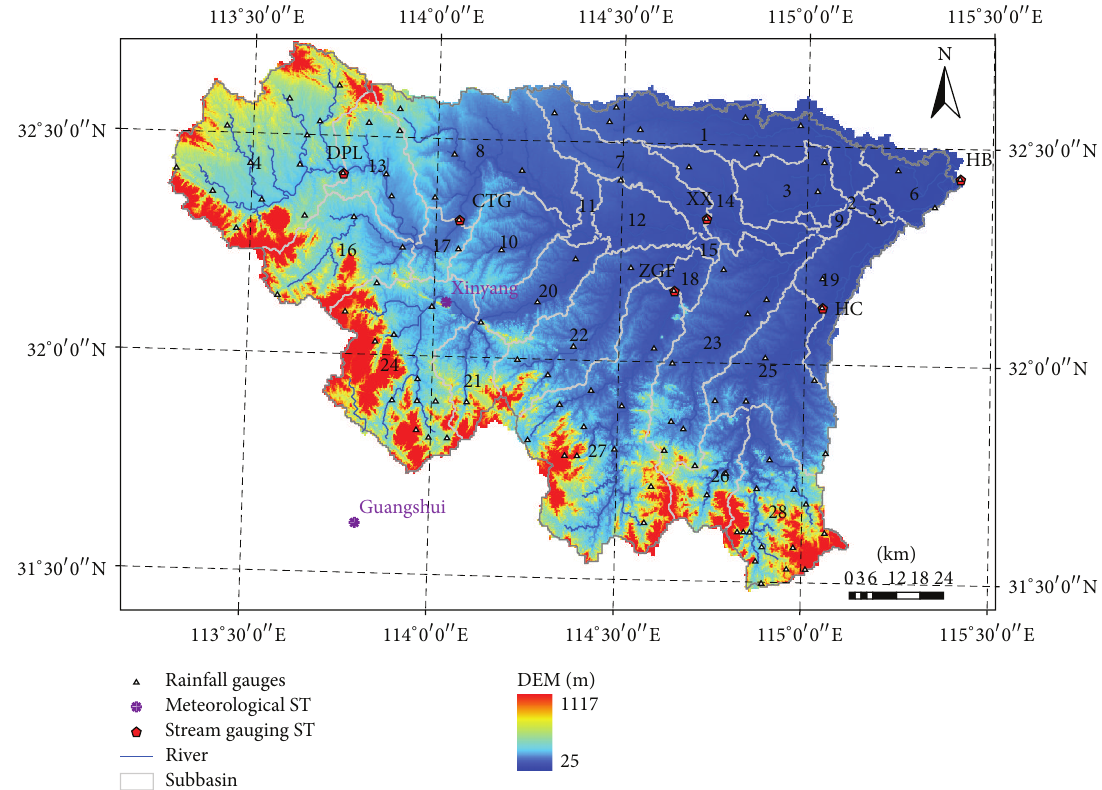
Figure 1: Upper Huai River basin (note: ST represents station; DPL, CTG, ZGF, XX, HC, and HB represent Dapoling, Changtaiguan, Zhuganfu, Xixian, Huangchuan, and Huaibin station, resp.; 1 to 28 represent the subbasin